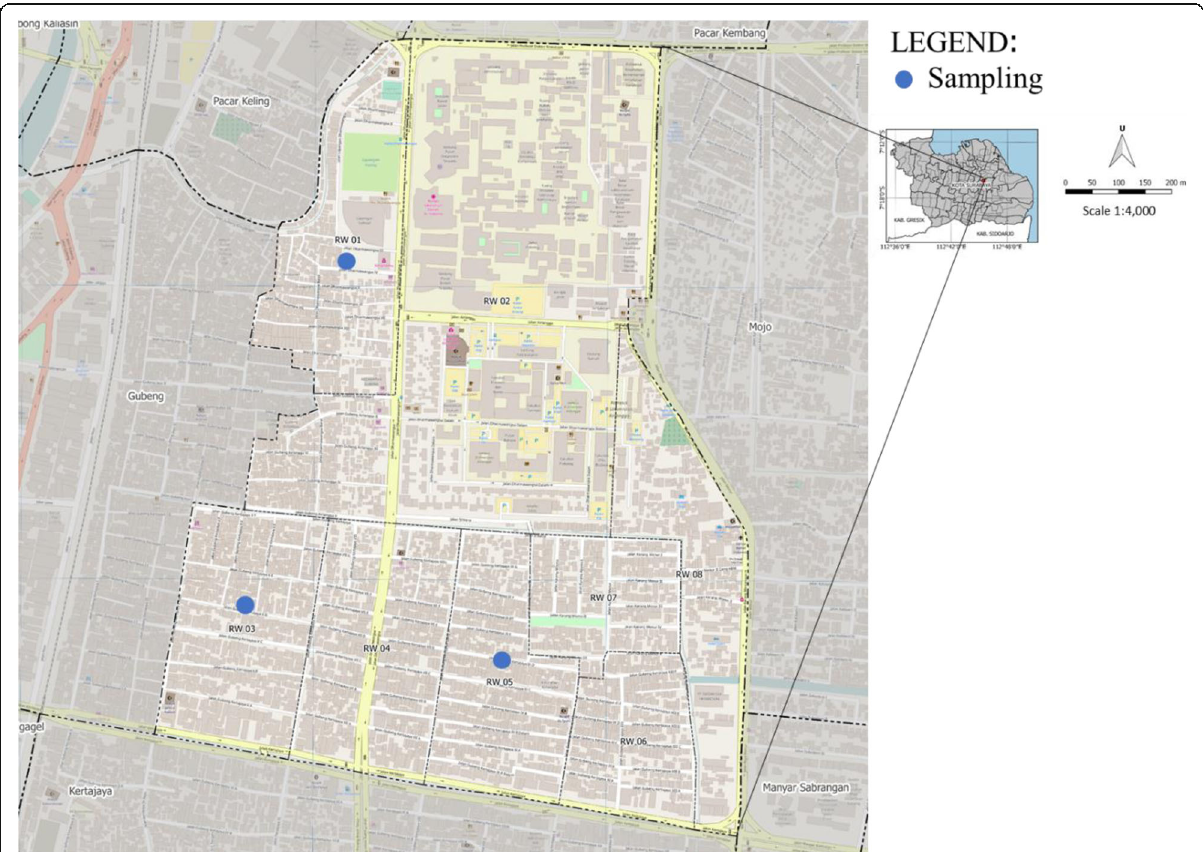
Fig. 1 Map of the sampling area in the context of